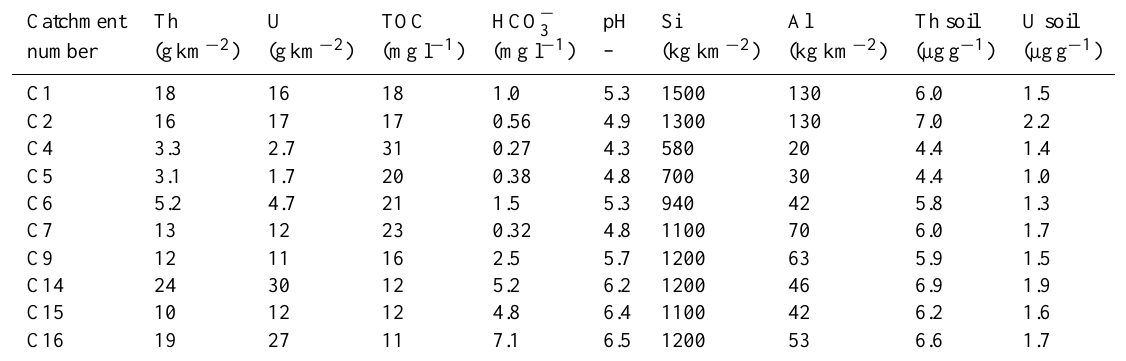
Table 2. Selected chemical characteristics of the investigated streams and catchments. The fluxes refer to the annual fluxes of each element, and pH and the concentrations of TOC and hydrogen carbonate are the volumetric averages of each stream. The concentrations of uranium and thorium in soil were determined by airborne gamma spectrometry.